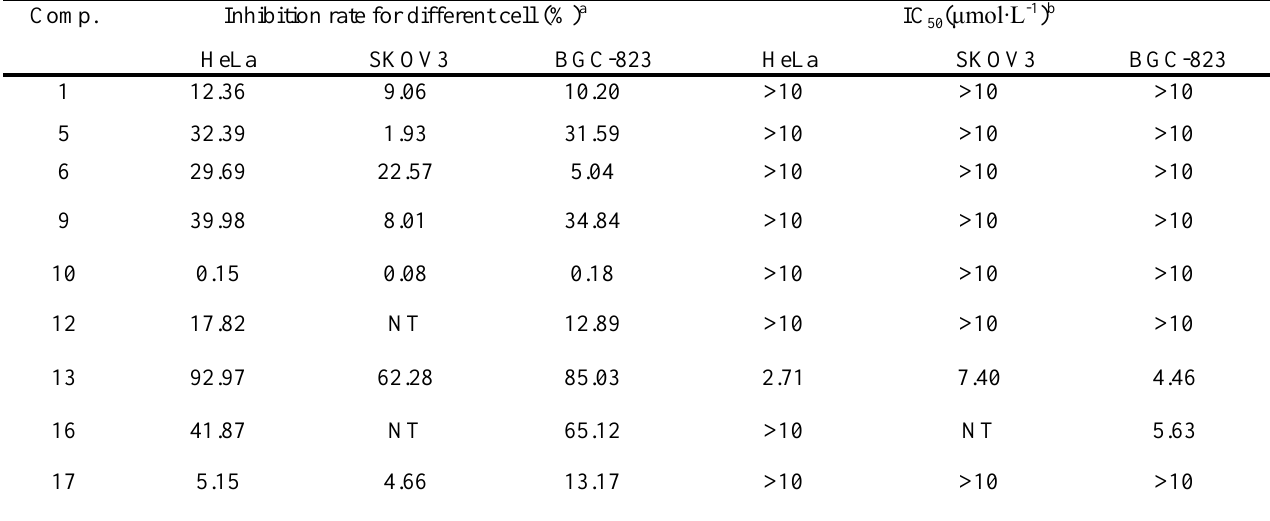
Table 1. Inhibitory activity of ursolic acid and its analogues on different cancer cell proliferation.